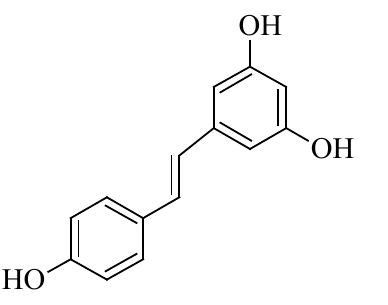
Figure 5. Chemical structure of